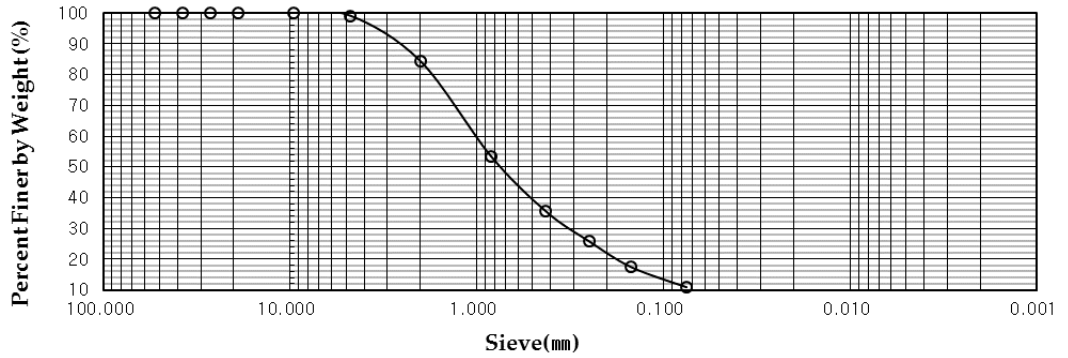
Figure 1. Compaction curve of soil to be tested.